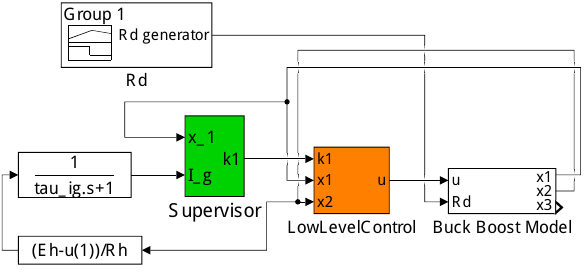
Figure 7. Simulink scheme of the considered control. The low-level Control is in the orange block, the high-level is in green.